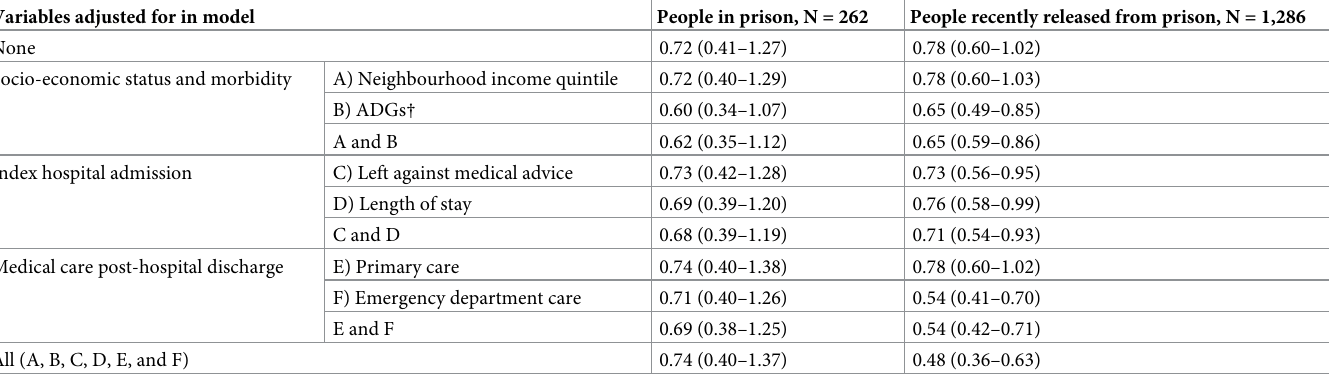
Table 3. Hazard ratios from Cox proportional hazards models for readmission by 30 days after medical-surgical hospitalization for people in prison and people recently released from prison � compared with age-, sex-, case mix group-matched people in the general population in Ontario, Canada. Variables adjusted for in